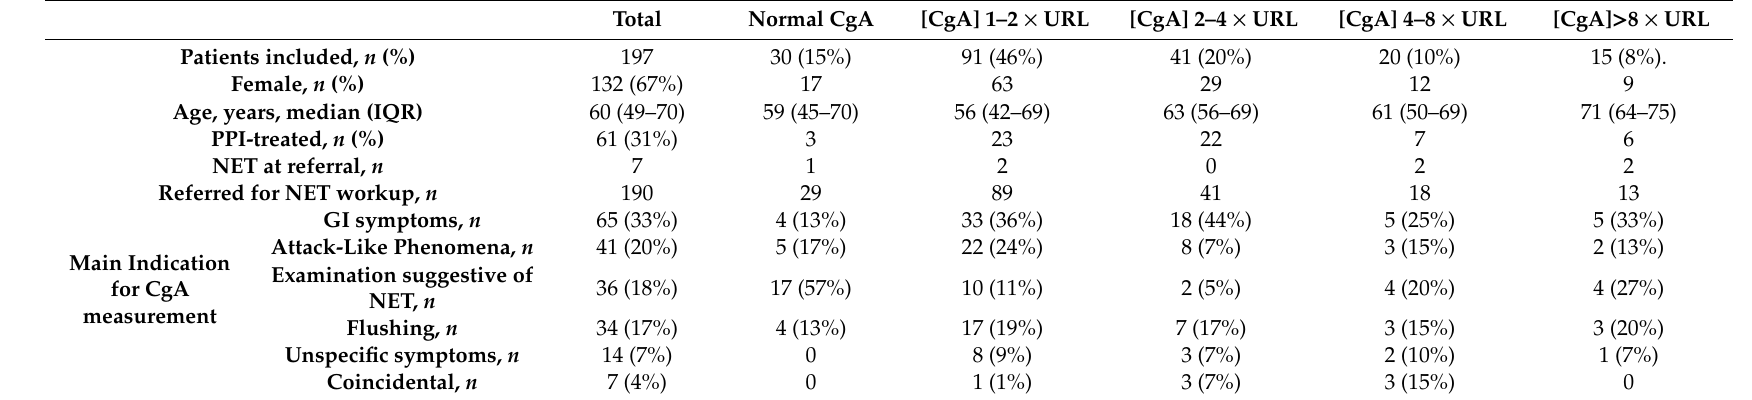
Table 1. Baseline characteristics.